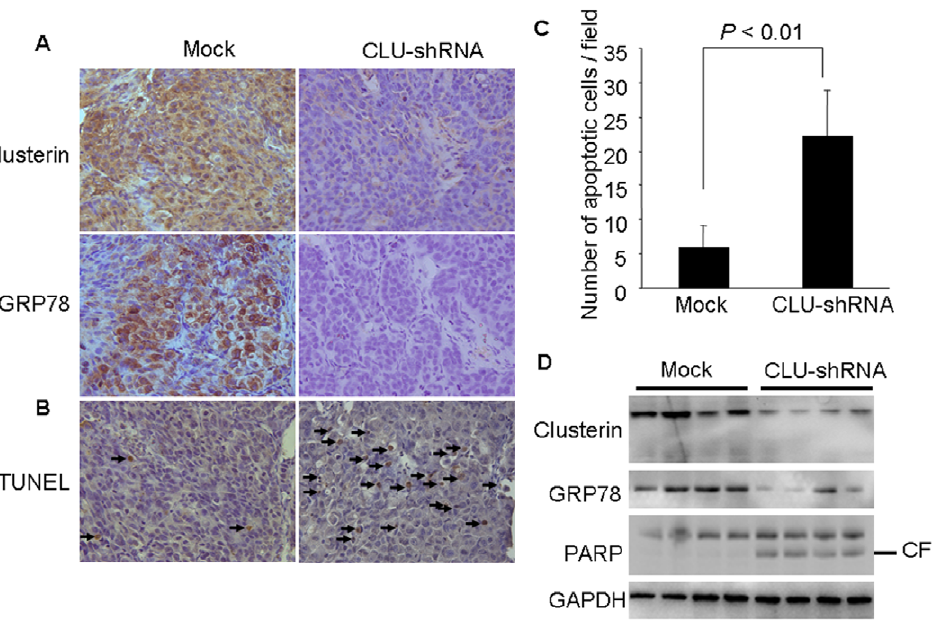
Figure 5. Silencing of CLU induces GRP78 down-regulation and cell apoptosis in vivo. (A) Immunohistochemistry staining with anti-CLU and anti-GRP78 were performed on serial sections of tumor specimen ( 6 400). (B–C) The apoptotic cells were identified by TUNEL staining. The number of TUNEL-positive cells in CLU-shRNA group was significantly elevated compared with mock group ( 6 400). (D) Total proteins were extracted from the xenograft tumors and CLU, GRP78 and PARP cleavage (CF, cleaved form) were analyzed by Western blotting.